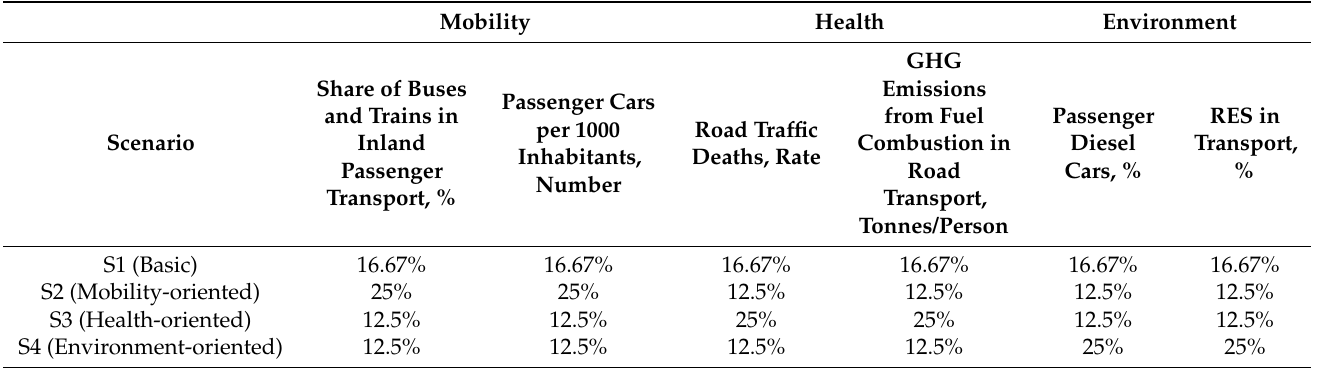
Table 1. Weighting schemes for sensitivity